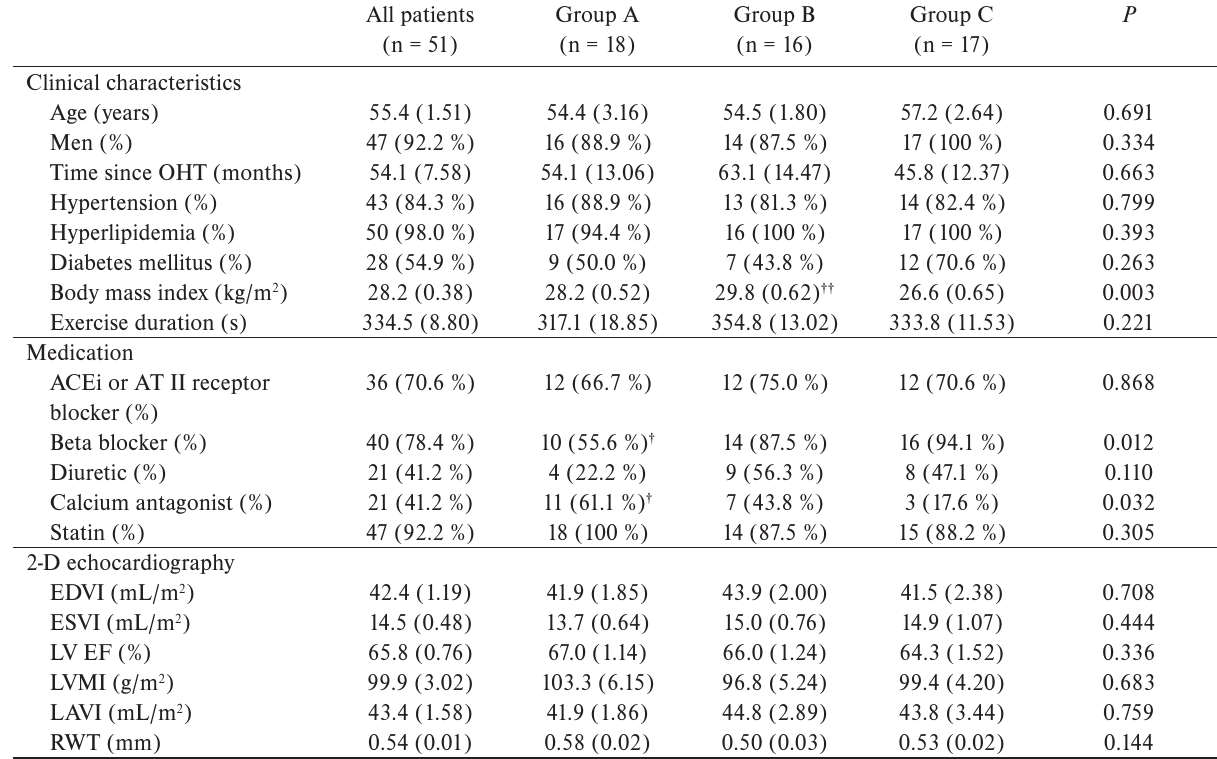
Table 1. Baseline clinical and echocardiographic data of all patients and those grouped according to post-exercise pulmonary capillary wedge pressure